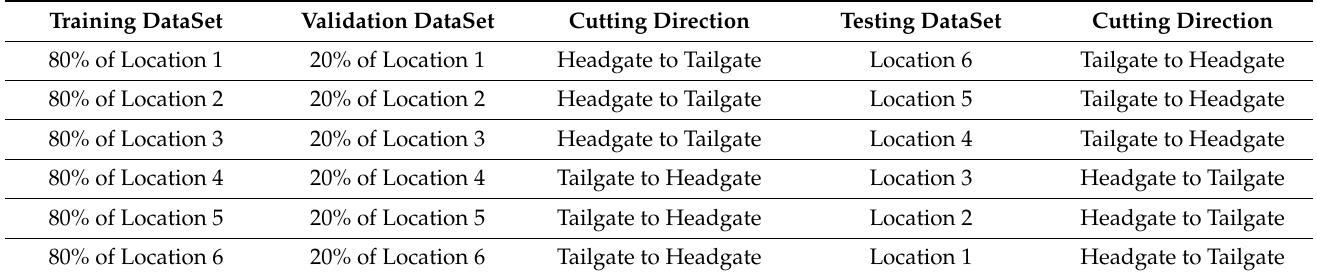
Table 1. Training, validation, and testing datasets based on shearer